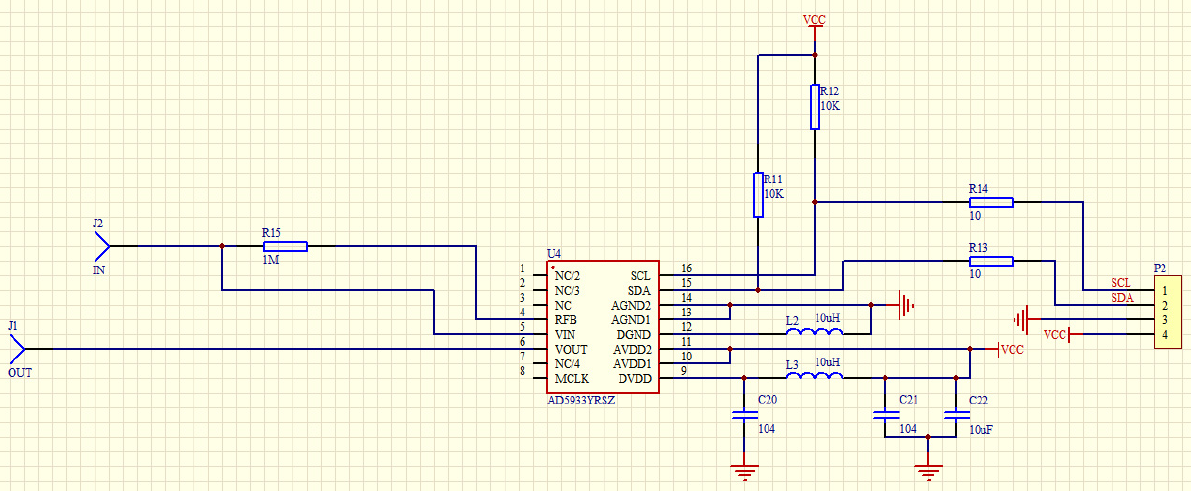
Figure 4. AD5933 peripheral circuit diagram.